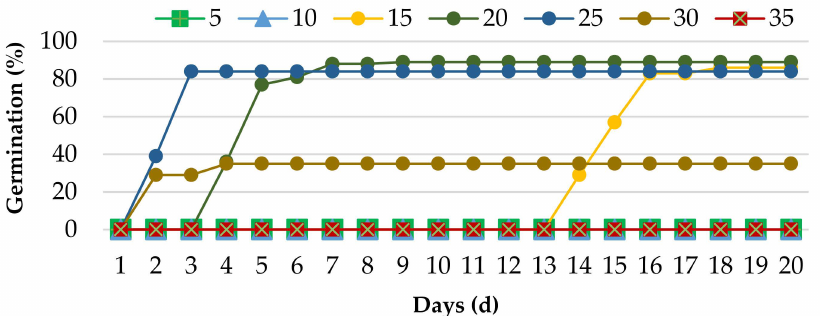
Figure 2. Germinated seeds on MS, Hf, of Dyckia brevifolia at 25 ◦ C after 3 ( A ) and 20 ( B ) days of culture in Petri dishes. Bars represent 1.0 cm of length.